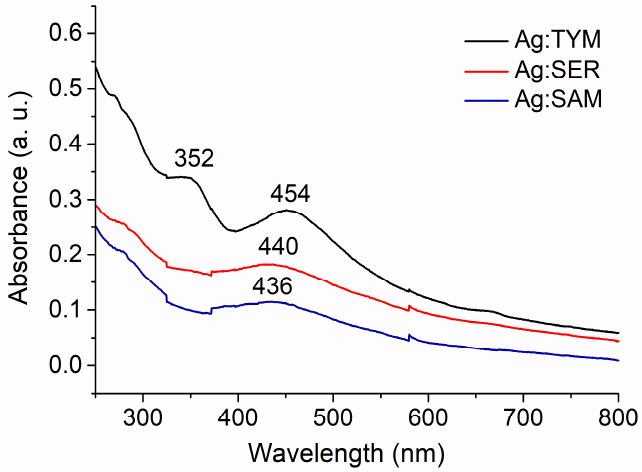
Figure 6. UV-Vis spectra of Ag:plant 1:1 W samples.